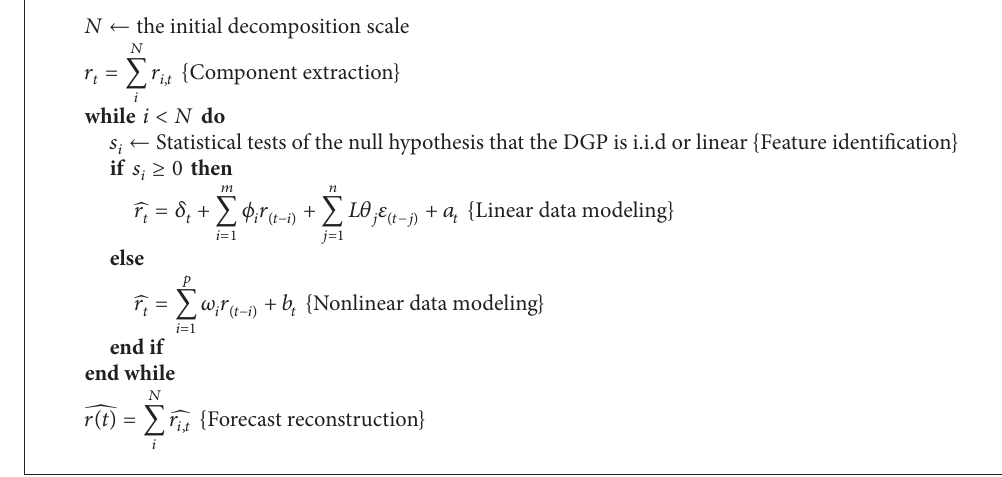
Algorithm 1: A MCA based hybrid methodology.